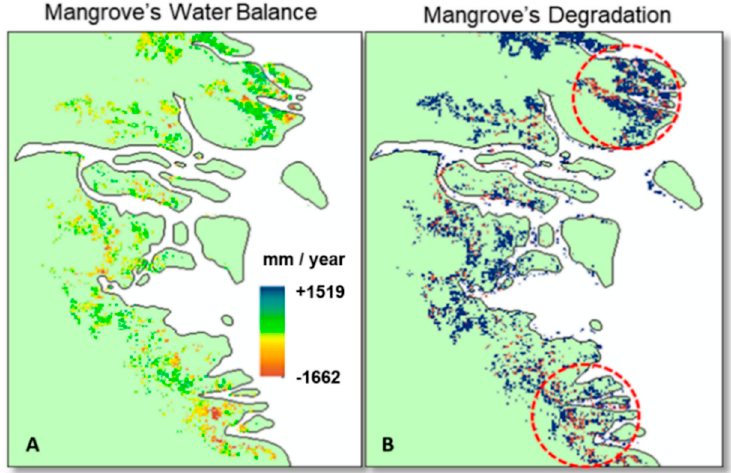
Figure 9. ( A ) Mangrove’s net water balance (in this study) and ( B ) mangrove’s net degradation between 2000 and 2012 in Southeast Asia.